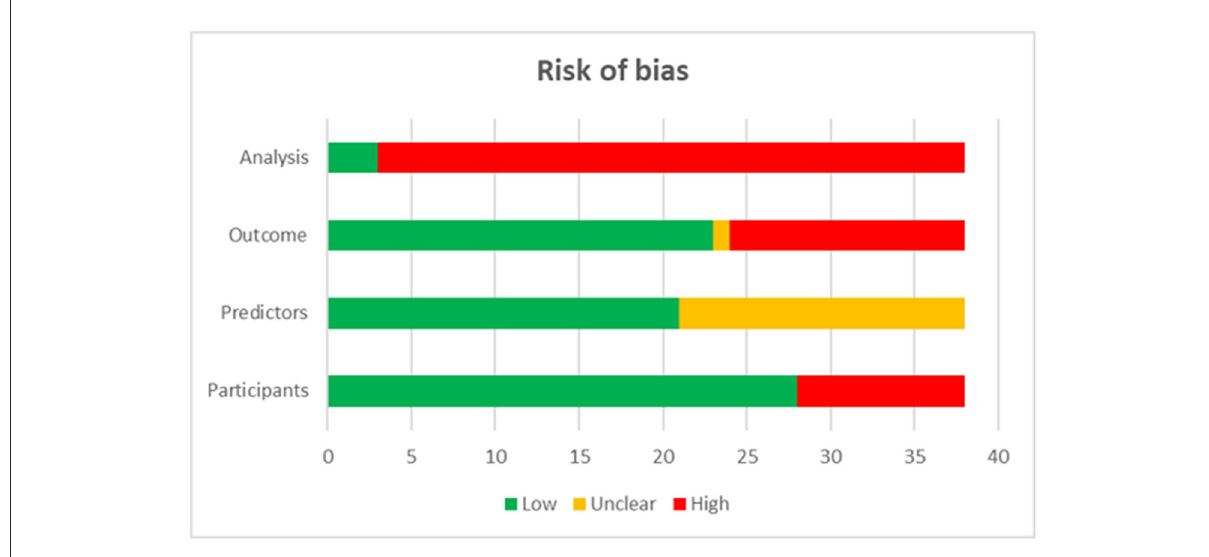
FIGURE1 Quality assessment of included